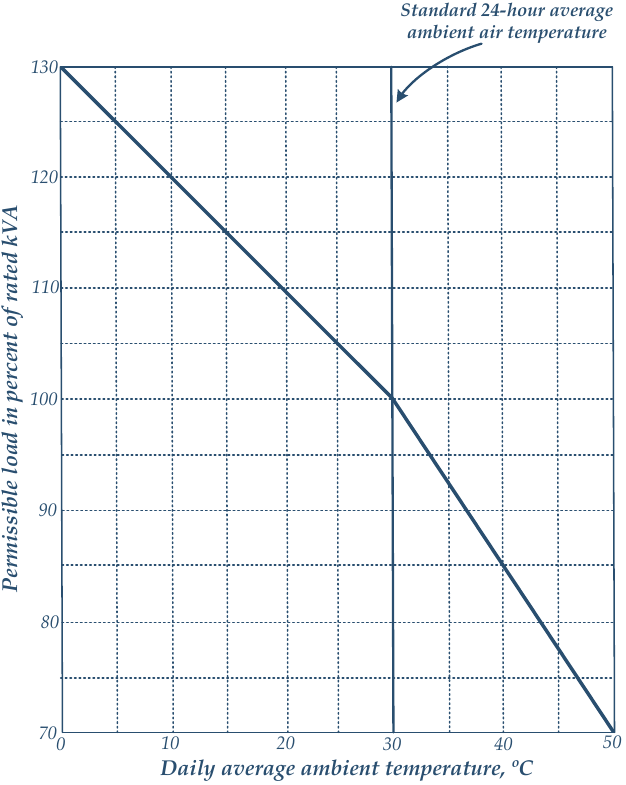
Figure 5. Permissible kVA loading by varying θ